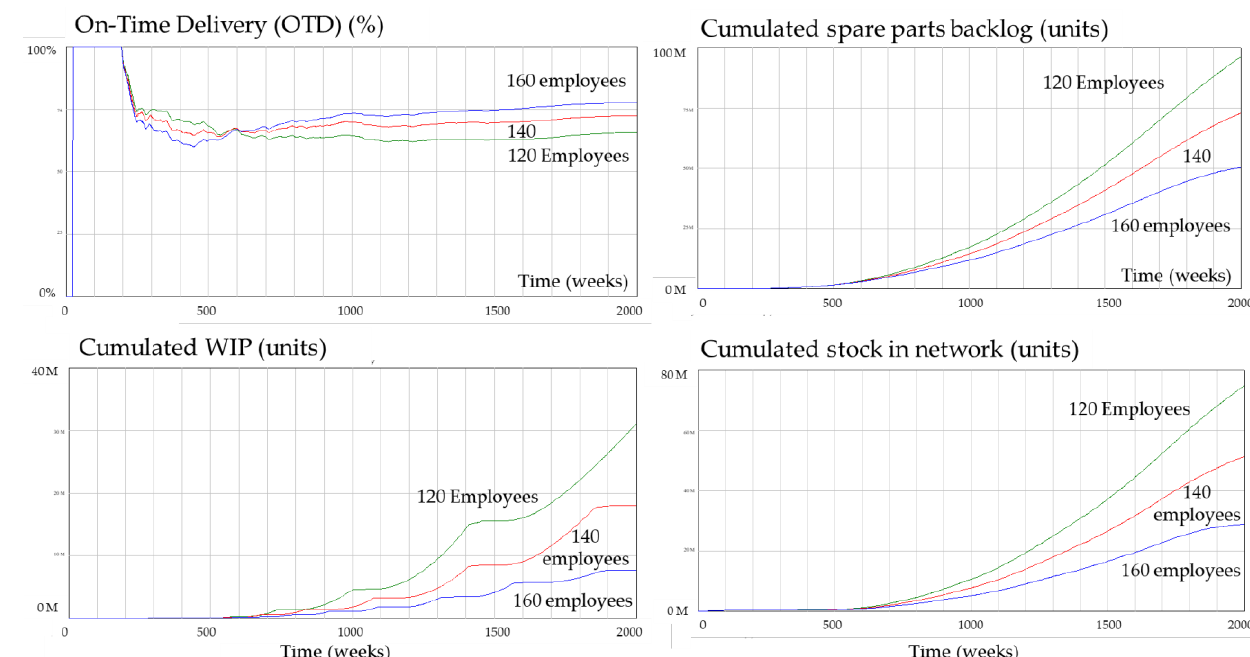
Figure 10. Model validation with the extreme test for the number of employees (own elaboration).